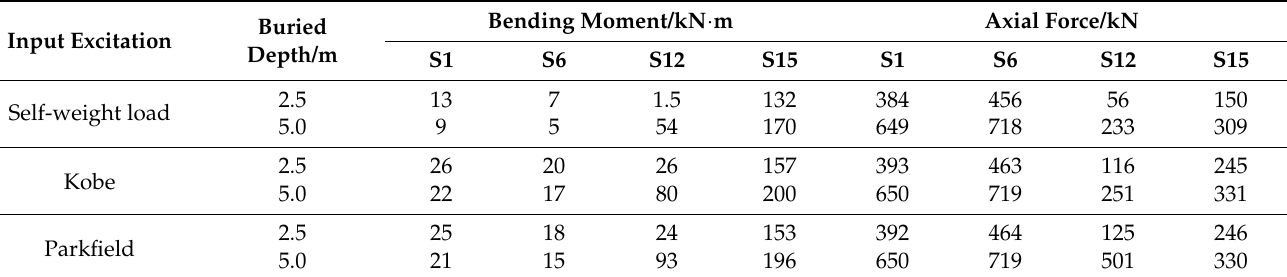
Table 5. The peak values of internal force with various buried depths.